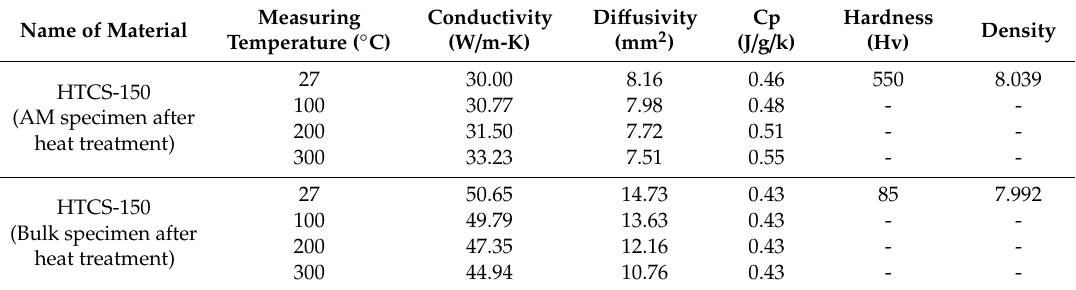
Table 5. Thermal conductivity and surface hardness of HTCS-150 without heat treatment.